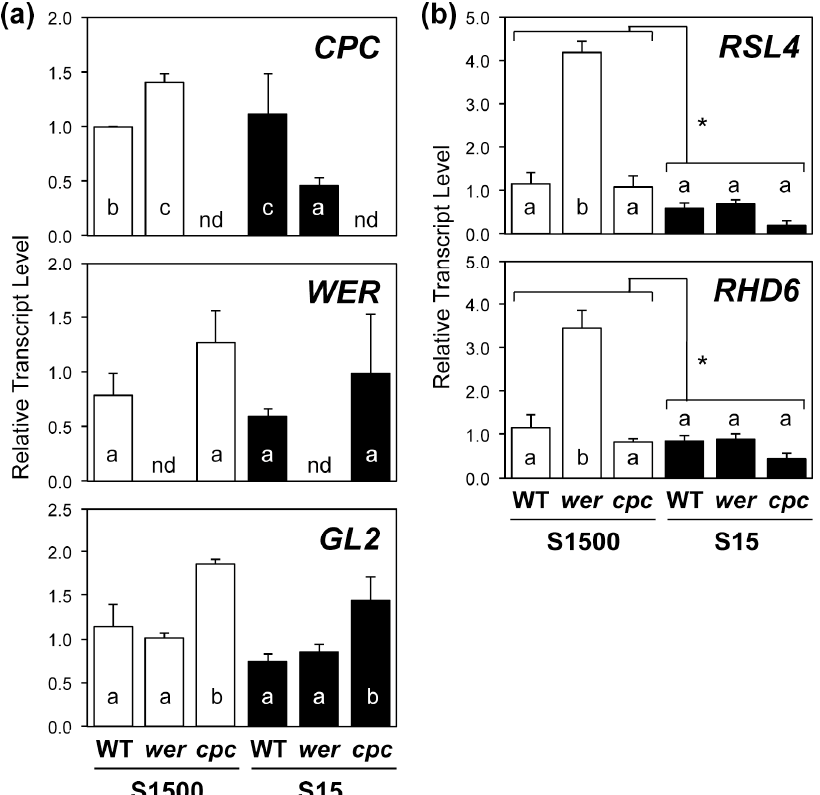
Figure 3. Expression of transcription factors regulating root hair development in wild-type (WT), werwolf ( wer) , and caprice ( cpc ) mutants grown under S1500 and S15 conditions. ( a ) Relative transcript levels of CPC, WER, and GL2, and ( b ) those of RHD6 , and RSL4, in root tissues were determined using quantitative reverse transcription-polymerase chain reaction (qRT-PCR). Plants were vertically grown for 10 d on S1500 (white bars) and S15 (black bars) agar media. Values and error bars indicate means ± SEM (n = 3). Two-way analysis of variance (ANOVA) was used to detect the effects of sulfur conditions, genotypes, and their interactions. In ( a ), all comparisons did not detect interactions, so the Tukey–Kramer test was applied to the three genotypes under the same growth conditions. In ( b ), interactions between sulfur conditions and genotypes were detected, so the Tukey–Kramer test was applied to all six experimental conditions. Different letters indicate significant differences ( P < 0.05).